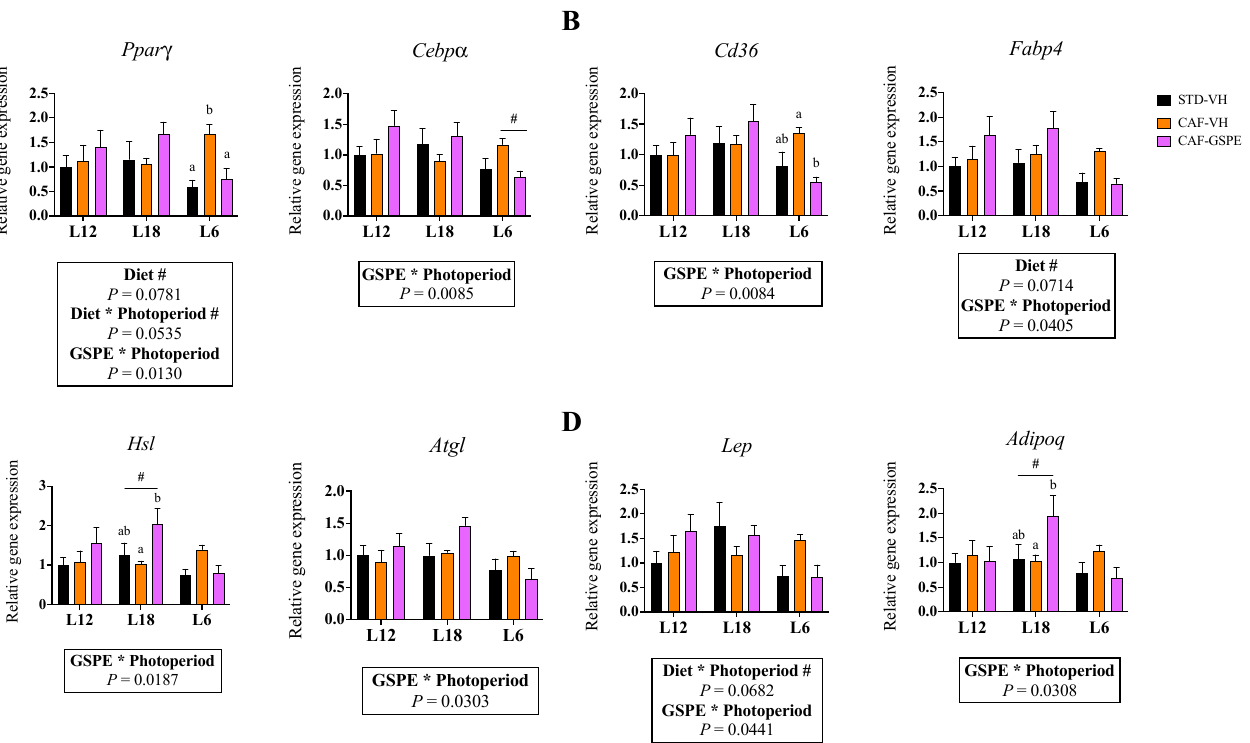
Figure 2. Effect of grape seed proanthocyanidin extract (GSPE) consumption at different photoperiods, 12 h of light:12 h of darkness (L12); 18 h of light:6 h of darkness (L18); 6 h of light:18 h of darkness (L6) on the expression of gens related to adipogenesis, lipogenesis, lipolysis and adipokines in inguinal white adipose tissue (iWAT) of diet-induced obese rats. Fisher 344 rats were fed standard diet (STD) or cafeteria diet (CAF) for 9 weeks and treated with GSPE (25 mg/kg body weight) or vehicle (VH) the last 4 weeks of the study; STD-VH group; CAF-VH group; CAF-GSPE group, under different photoperiods; L12, L18 or L6. The expression of genes involved in adipogenesis ( A ), lipogenesis ( B ), lipolysis ( C ) and adipokines ( D ) was measured by qPCR and normalized by Ppia . The relative expression (presented as fold-change) of CAF-VH and CAF-GSPE was normalized to the corresponding STD-VH control group (L12 photoperiod). Significant differences were assessed through two-way ANOVA analysis ( P < 0.05). Diet: diet effect within VH groups; Diet * Photoperiod: interaction effect between diet and photoperiod within VH groups; GSPE * Photoperiod: interaction effect between GSPE consumption and photoperiod within CAF groups. Different letters denote significant differences within each photoperiod group (assessed with two-way ANOVA followed by Tukey’s post hoc test, p < 0.05; # : tendency: 0.05 < P < 1)